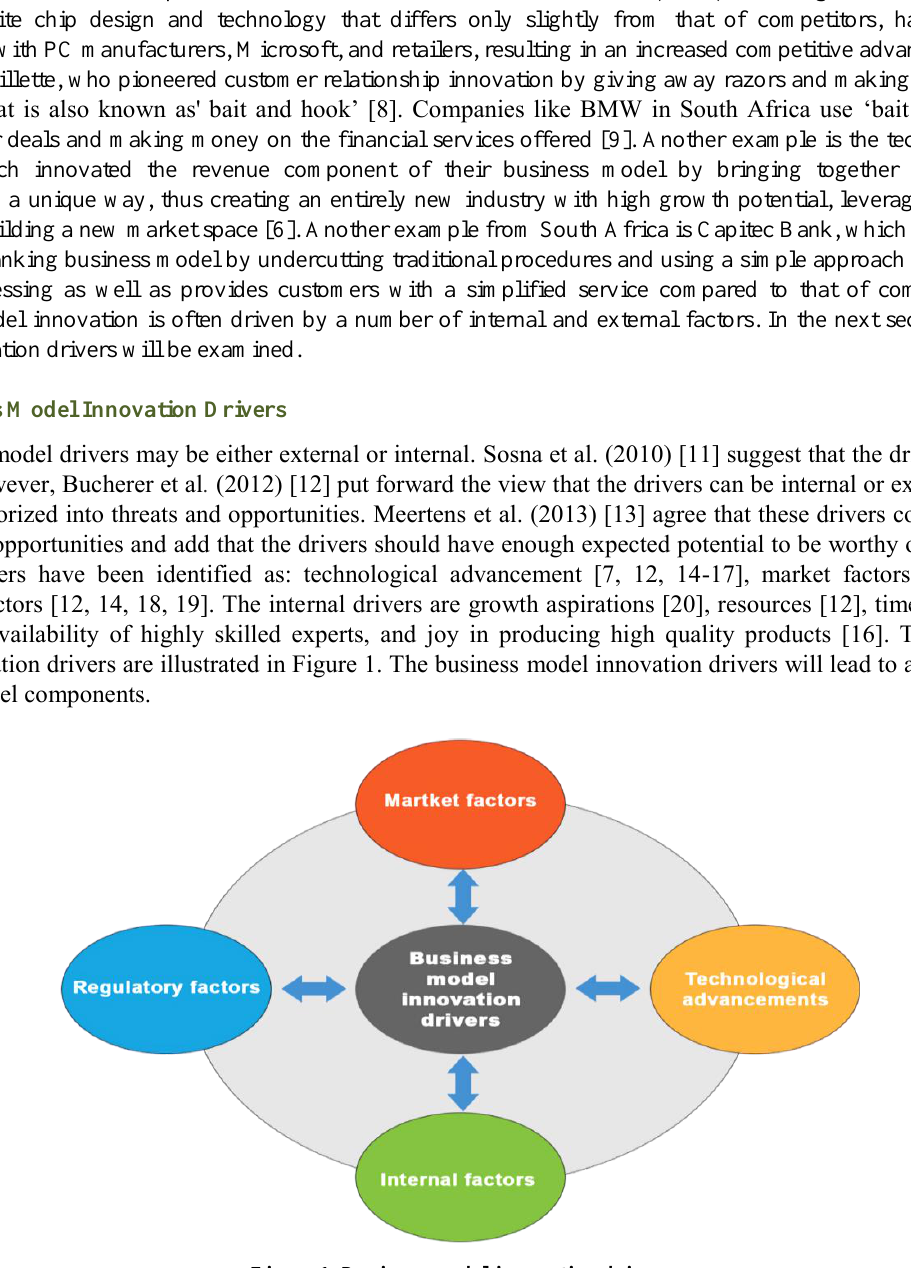
Figure 1. Business model innovation